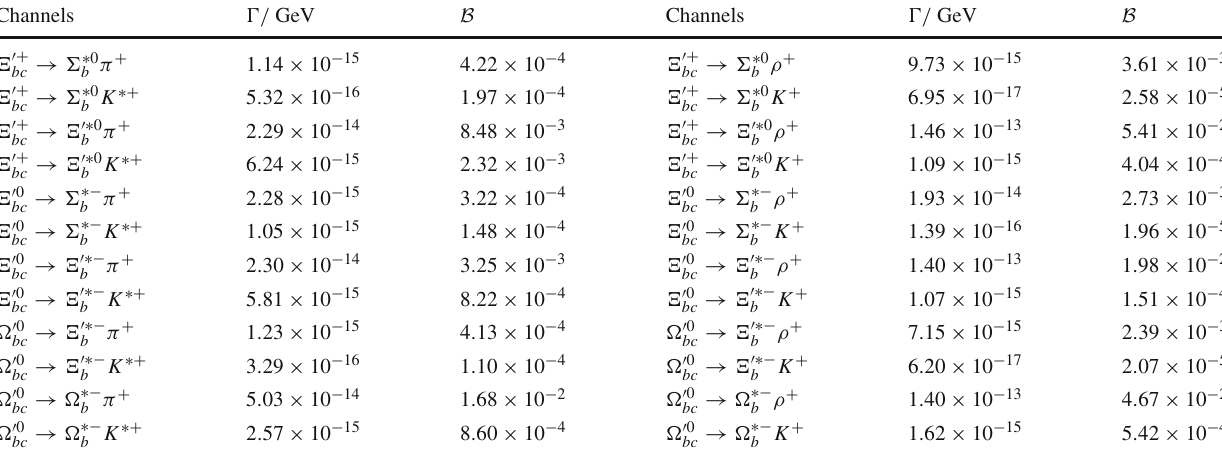
Table 20 Nonleptonic decays for the bc (cid:3) sector with c quark decay